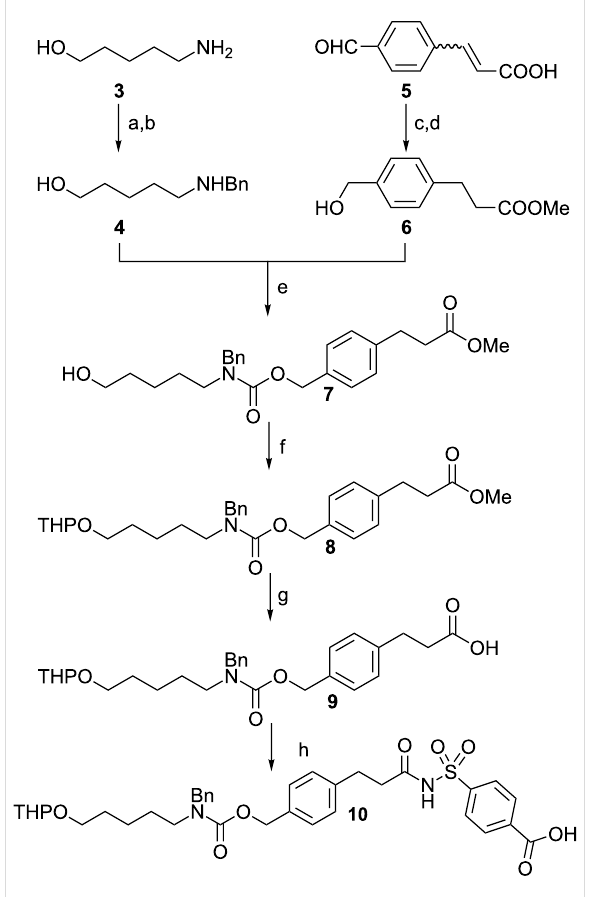
Scheme 1: Synthesis of a new acylsulfonamide safety-catch linker. Reagents and conditions: (a) benzaldehyde, Na 2 SO 4 , DCM;